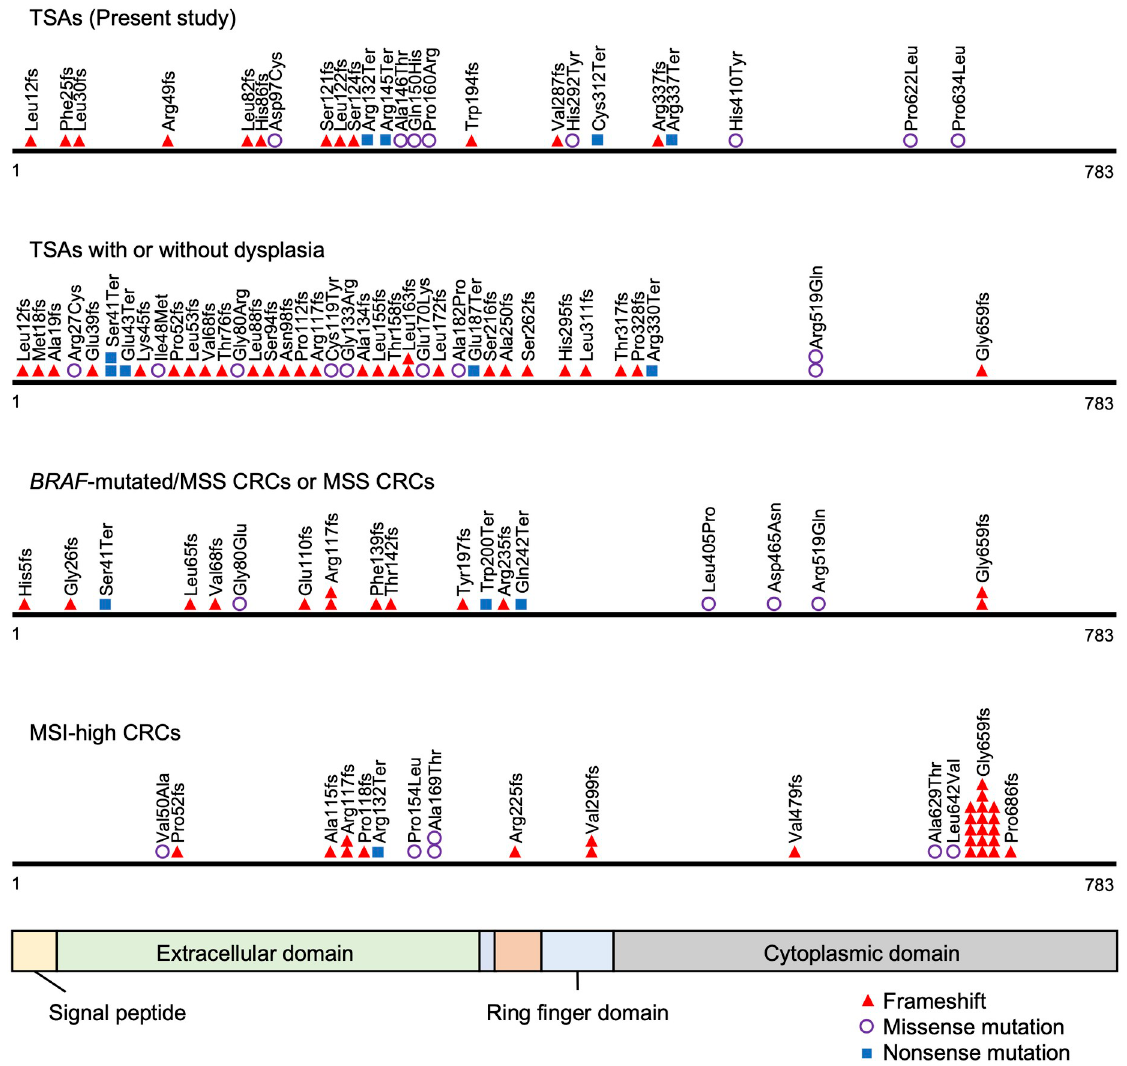
Fig 2. Distributions of RNF43 mutations in detected in TSAs in the present study. Previously reported TSA mutations with or without dysplasia as well as MSS and MSI-high CRCs are shown for reference